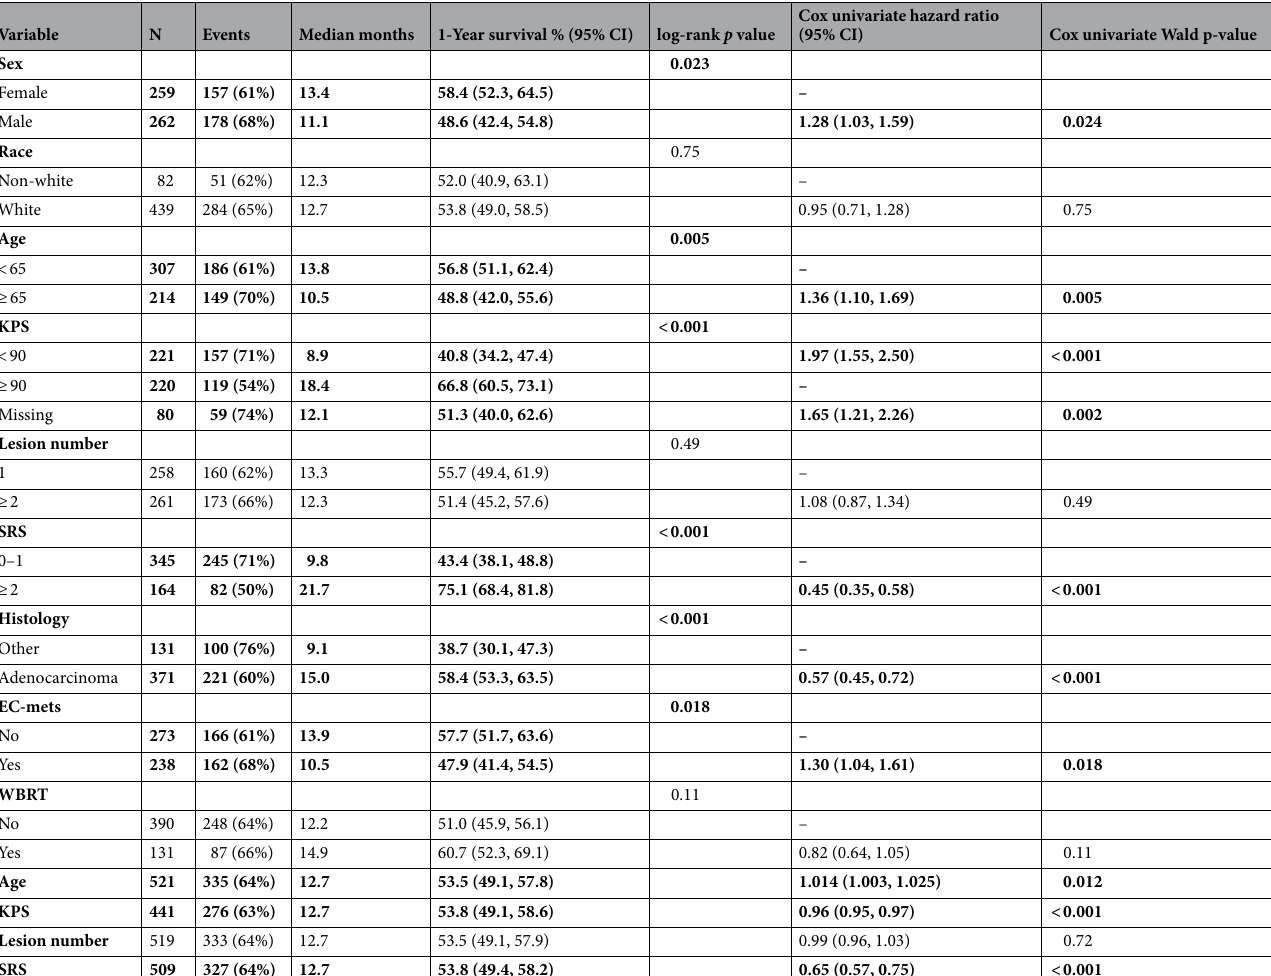
Table 2. Univariate analysis of demographics and clinical characteristics. Significant differences (p < 0.05) are bolded.